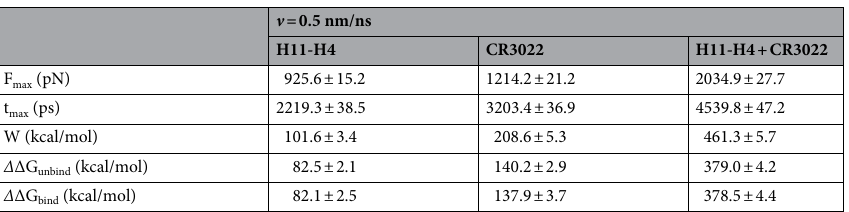
Table 2. Rupture force ( F max ), rupture time ( t max ), work of the external force ( W ), and non-equilibrium binding free energy ∆G bind and ∆G unbind for the H11-H4–RBD, CR3022–RBD, and H11-H4 + CR3022–RBD complexes. The results were obtained from five independent SMD trajectories for the WT case at a pulling speed of v = 0.5 nm/ns. The errors represent standard